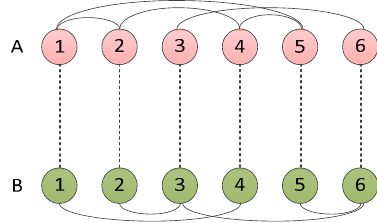
Figure 1. Interdependency diagram.